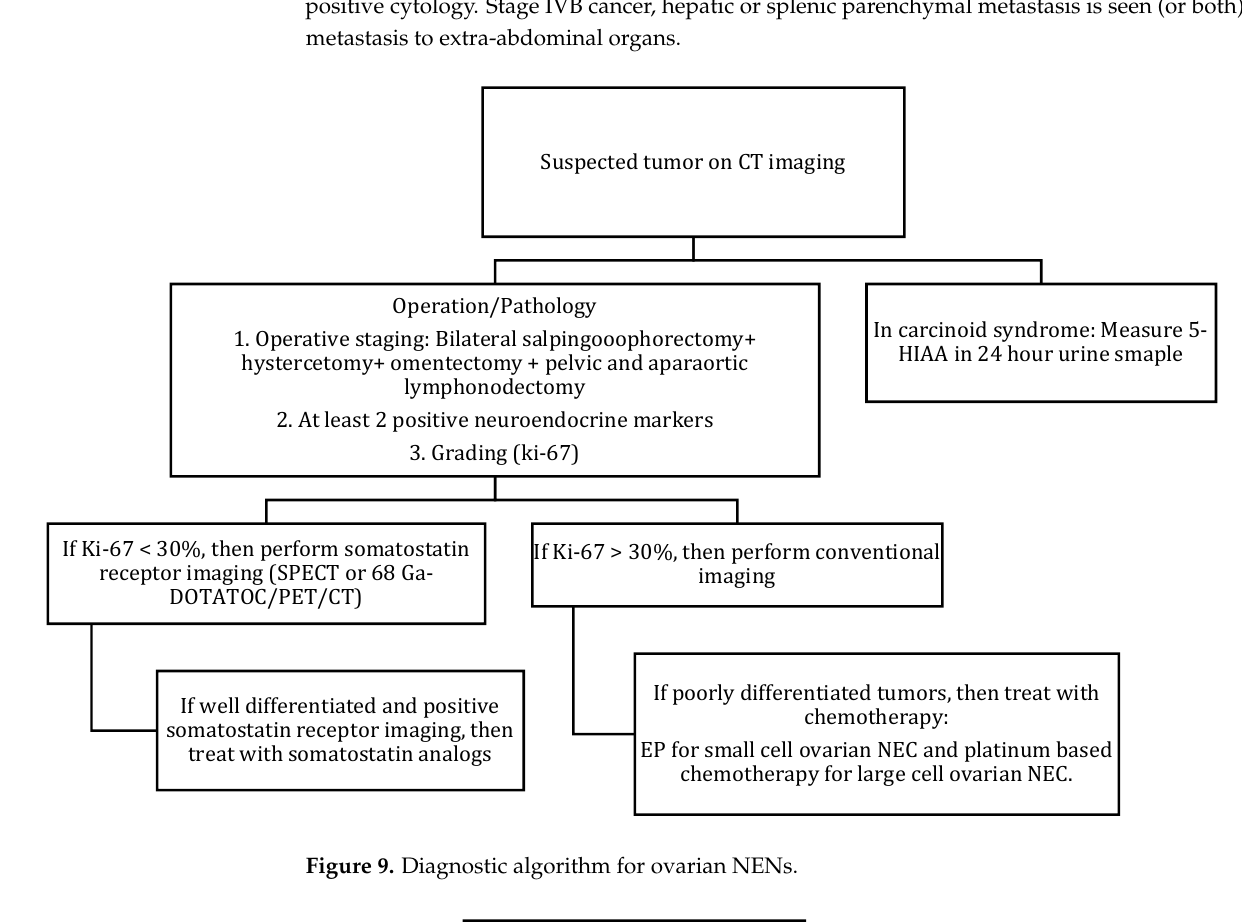
Figure 9. Diagnostic algorithm for ovarian NENs.